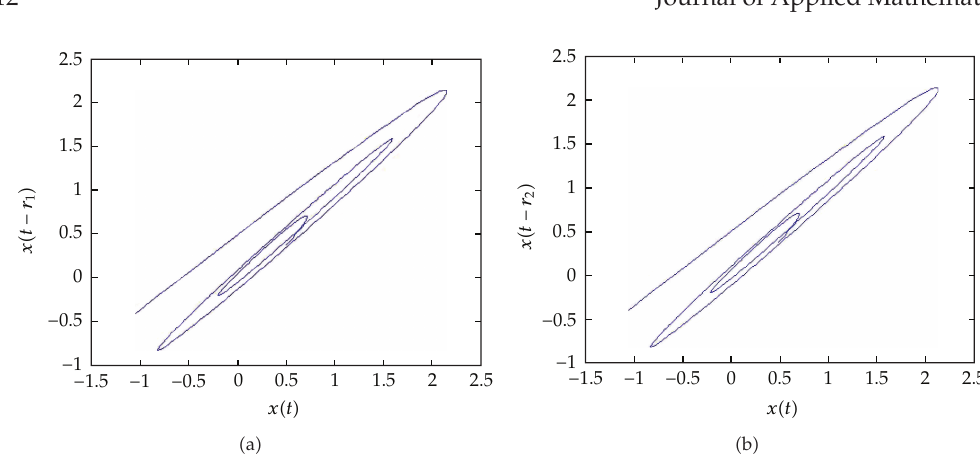
Figure 4: Show phase portrait of the system, that is, plot of x (cid:3) t (cid:4) versus x (cid:3) t − r 1 (cid:4) (cid:3) a (cid:4) and plot of x (cid:3) t (cid:4) versus x (cid:3) t − r 2 (cid:4) (cid:3) b (cid:4) at r 1 (cid:8) 0 . 7, r 2 (cid:8) 0 . 7, and α (cid:8) 0 . 85.